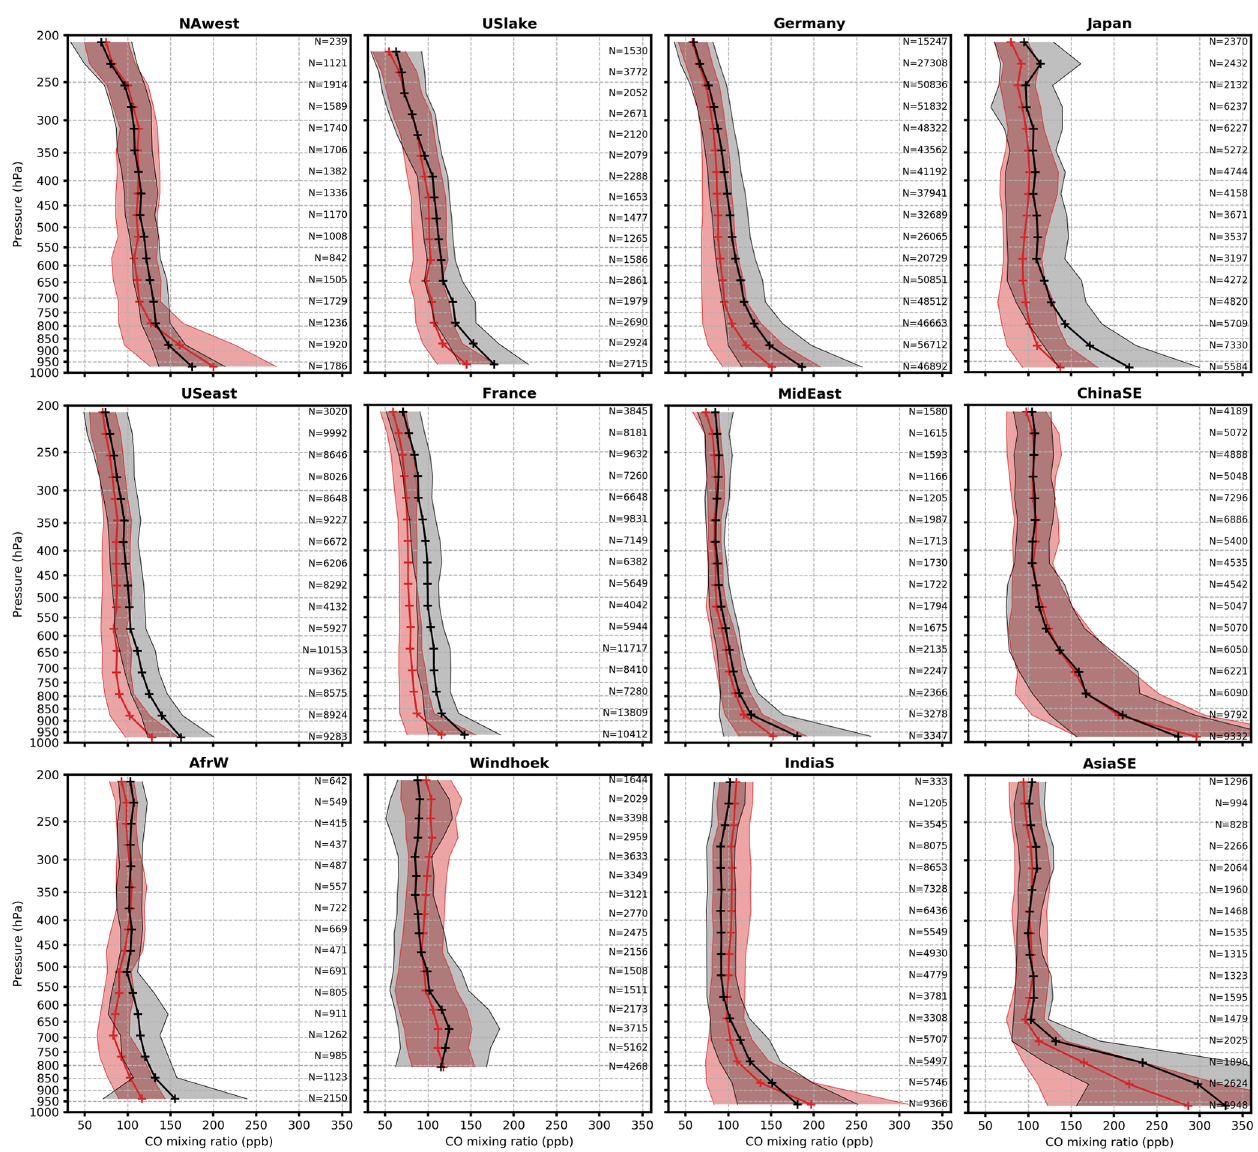
Figure 11. Comparison between IAGOS (in black) and MOCAGE INJH (in red) 2013 mean vertical CO profiles at the 12 airport clusters defined in Table 5. The shaded grey and red areas represent, respectively, the standard deviation around the IAGOS and the MOCAGE mean. The number of data points used for each pressure level mean is indicated on the right side of each